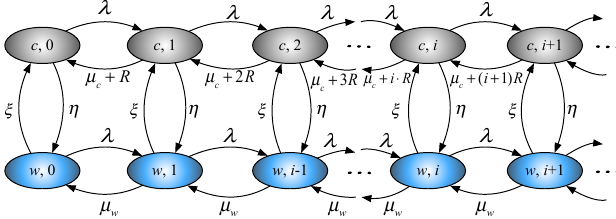
Figure 3: The 2D Markov chain for the partial off- loading model with cellular and WiFi